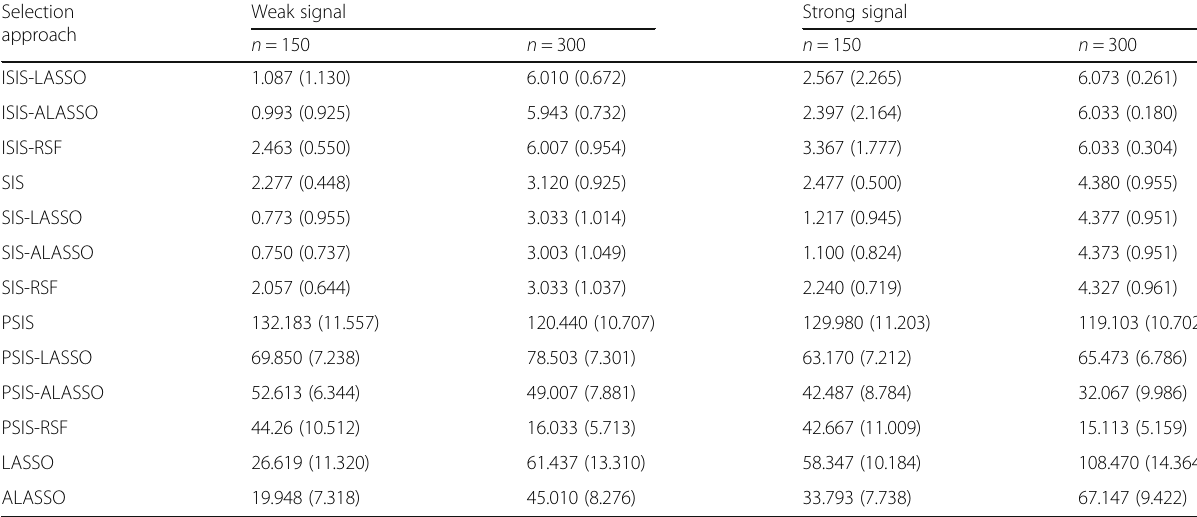
Table 2 Mean (SD) of final model size for the training sets over 300 simulations Selection approach